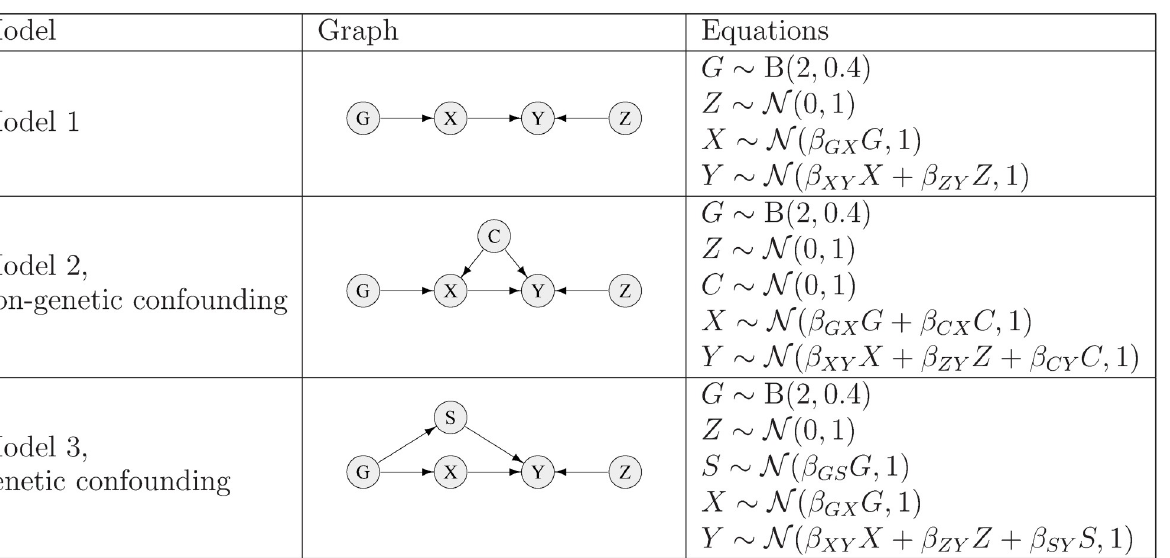
was varied using values of 0.0, XY Y þ b G ; 1 Þ and Y � N ð b Z ; 1 Þ , with YX GX ZY